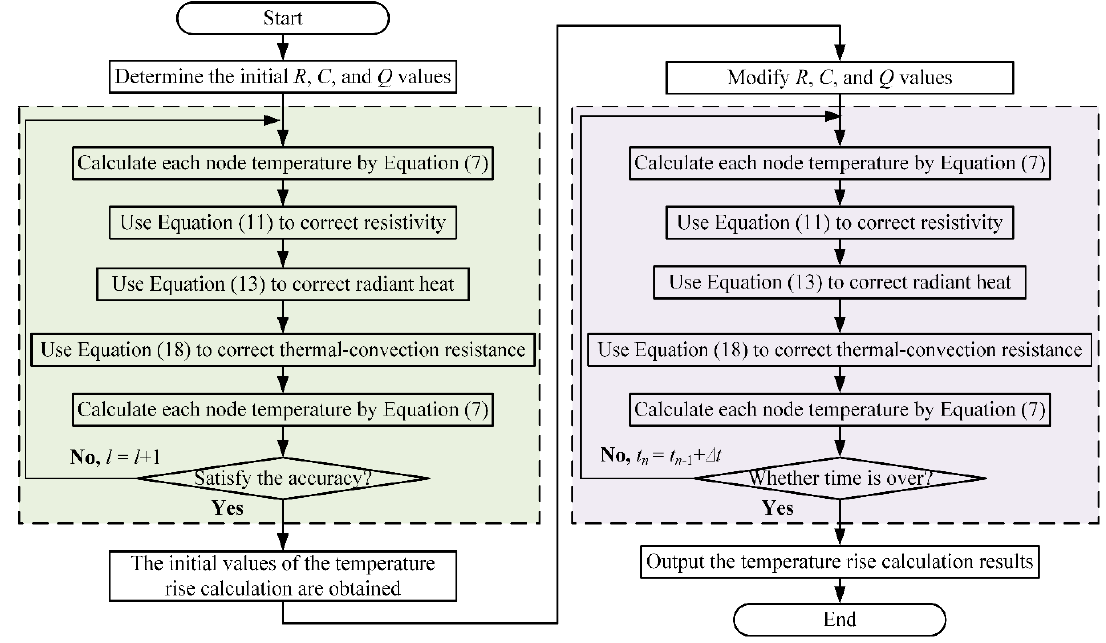
Figure 4. Transient temperature calculation method of overhead transmission line with nonlinear iteration.